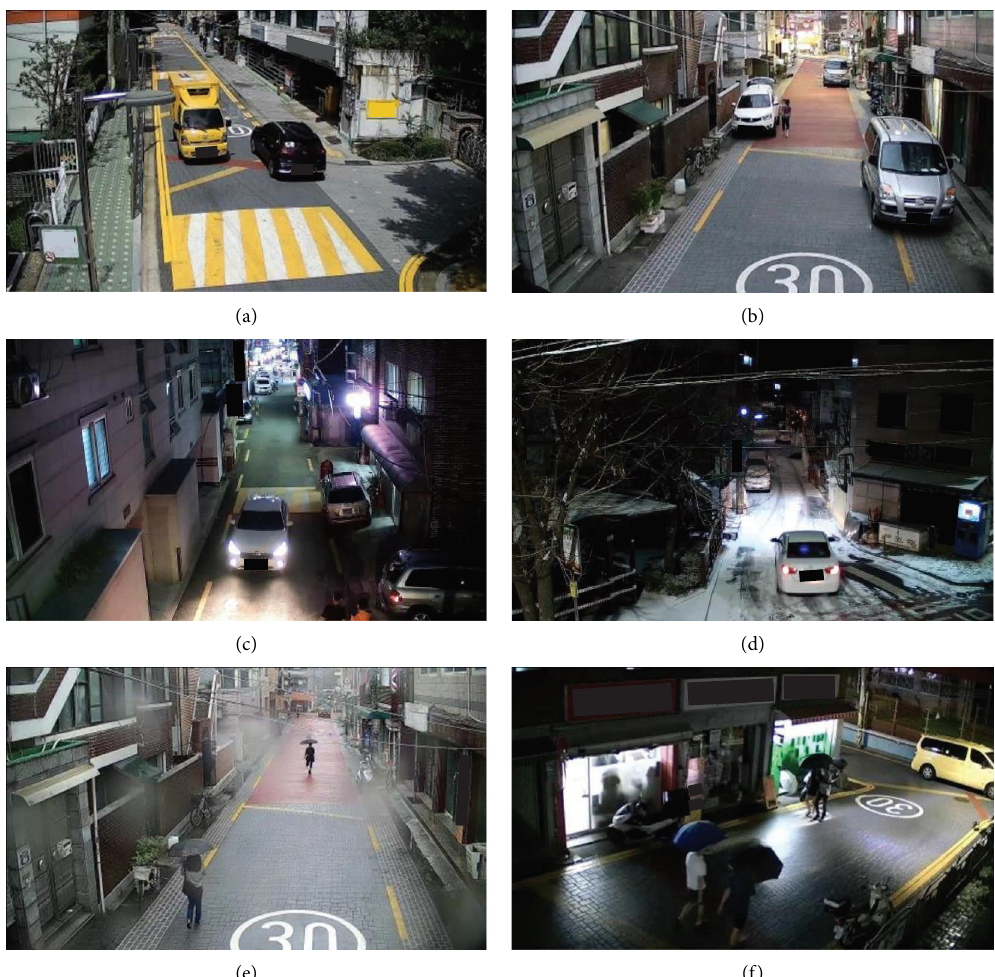
Figure 2: Various environments for training model. Te model was trained in various lighting conditions, including clear (a, b, c), snowy (d), and rainy weather (e,